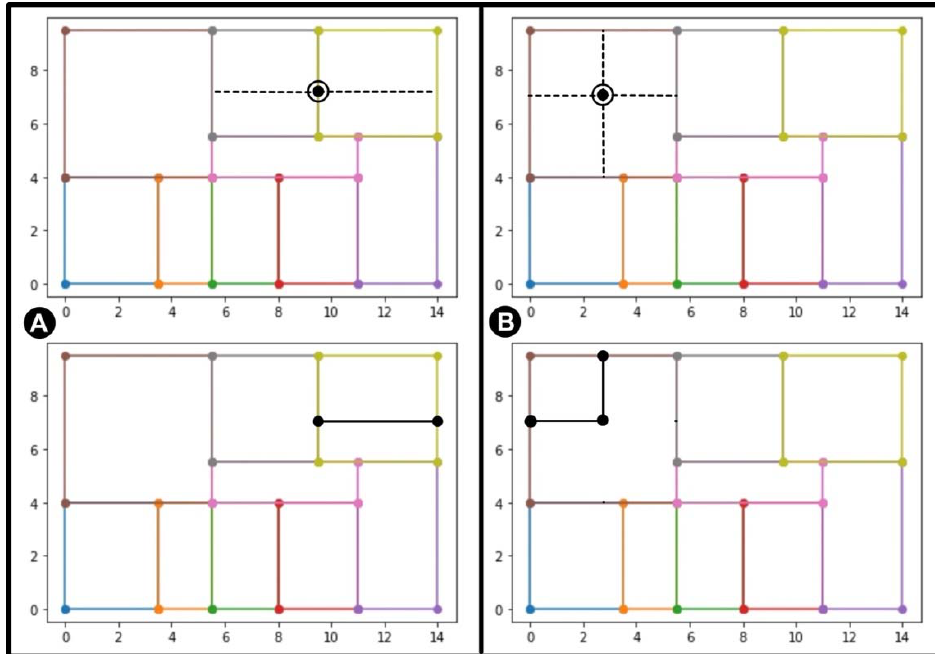
Figure 4. Adding a new point mutation example (A) on the existing wall and (B) inside a room.